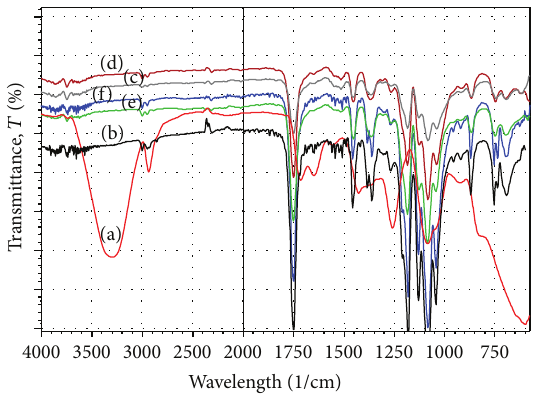
Figure 1: FT-IR spectra of (a) pure PLA, (b) PLA/FS, (c) 2wt% of PLA/FS/clay (1.28E) nanocomposite, (d) 5wt% of PLA/FS/clay (1.28E)nanocomposite,(e)10 wt%ofPLA/FS/clay(1.28E)nanocom- posite, and (f) 15 wt% of PLA/FS/clay (1.28E) nanocomposite.